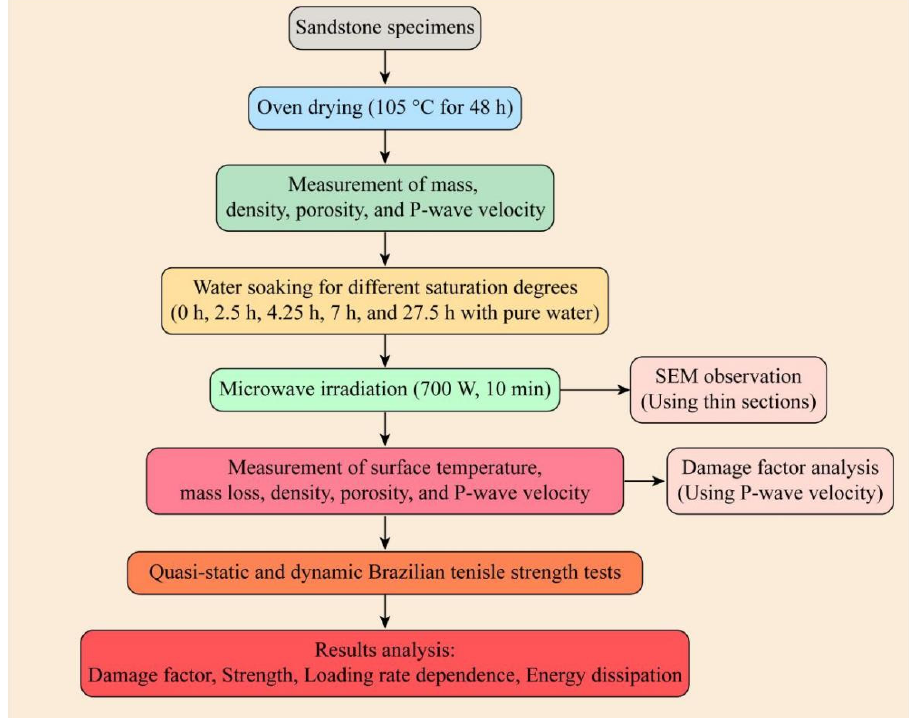
Figure 4. Flowchart of the microwave treatment and experimental procedure.